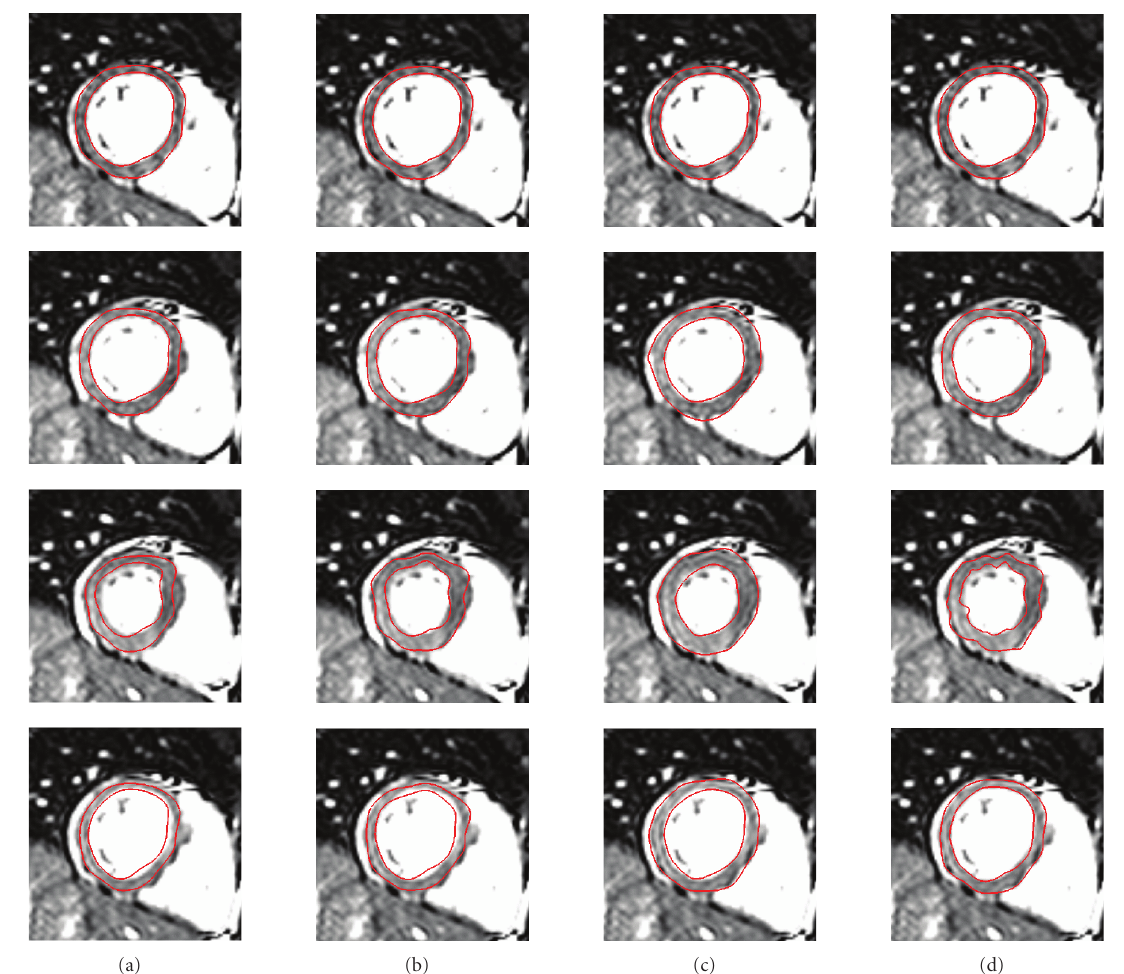
Figure 2: The recovered myocardial deformation for a normal subject over the cardiac cycle (first row: end diastole; third row: end systole) is shown by means of the endocardial and endocardial surface model contours overlaid over a midventricular short-axis MRI slice. The myocardium was segmented in the first frame (shown in the first row), a surface model was generated around the segmented myocardium and the recovered deformation for the rest of the sequence was applied to the surface model. The two red contours represent a cross-section through the surface model. The four columns correspond to (a) sequential recovery by Γ 1 , (b) sequential recovery by Γ 2 , (c) reference- based recovery by Γ 1 , and (d) reference-based recovery by Γ 2 . The registration algorithms Γ 1 and Γ 2 and the di ff erence between sequential and reference-based recovery are explained in Section 3.2. Note that the best deformation recovery, that is, the best agreement of the red contours and the edges of the left ventricular wall, was achieved for the reference-based recovery by Γ 1 , shown in column